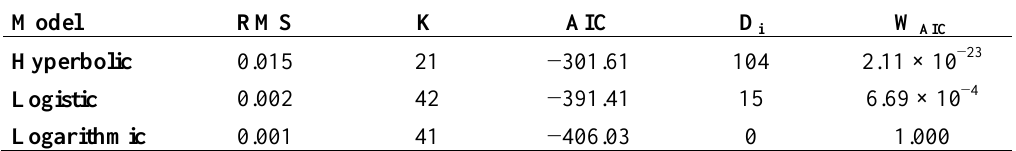
Table 2. Outcome of the  model comparison according to Akaike information criterion [40]: residual mean squares (RMS), total number of parameters (K—number of parameters of the model including the variance of the estimated residuals),